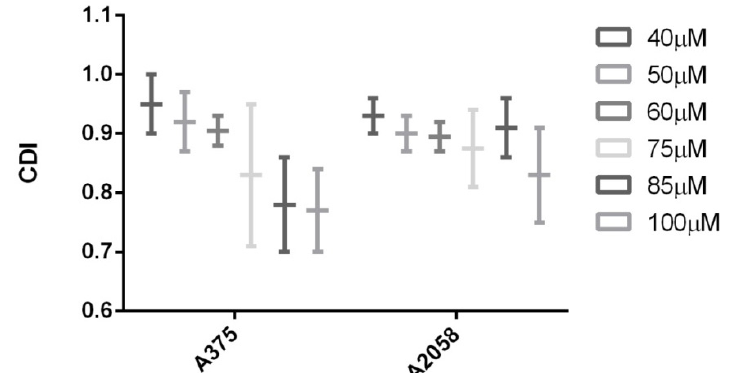
Figure 6. The synergistic antiproliferative effect of OA:HPGCD combined with UA: HPGCD on the growth of A375 and A2058 cell lines. CDI (coefficient of drug interaction) was calculated as follows: CDI = AB/(A × B), where AB represents the ratio between the absorbancy values of the mixture (OA + UA) and control groups while A or B are the ratio between the absorbancy values of the single agent and the control